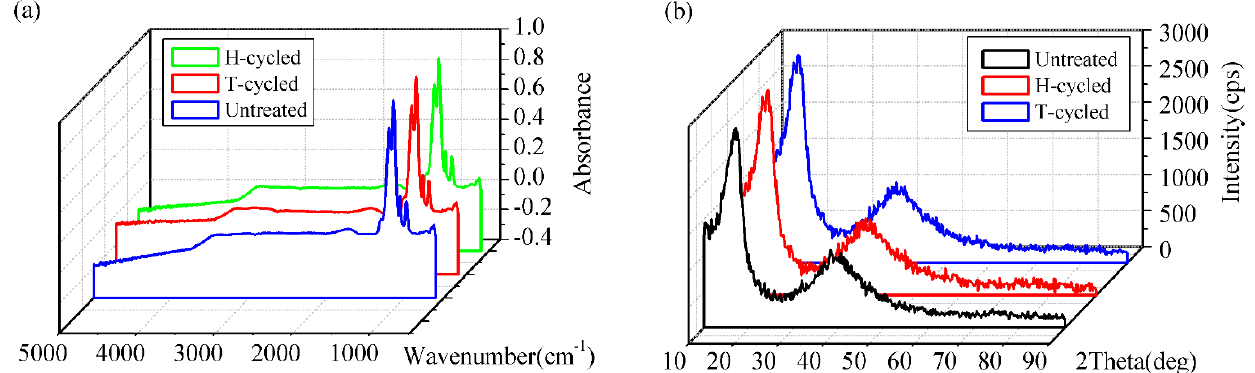
Figure 5. ( a ) Fourier transform infrared spectroscopy (FT-IR) spectra of Nafion membrane specimens, untreated, humidity cycling aged and temperature cycling aged; ( b ) X-ray diffraction (XRD) spectra of Nafion membrane specimens, untreated, humidity cycling aged and temperature cycling